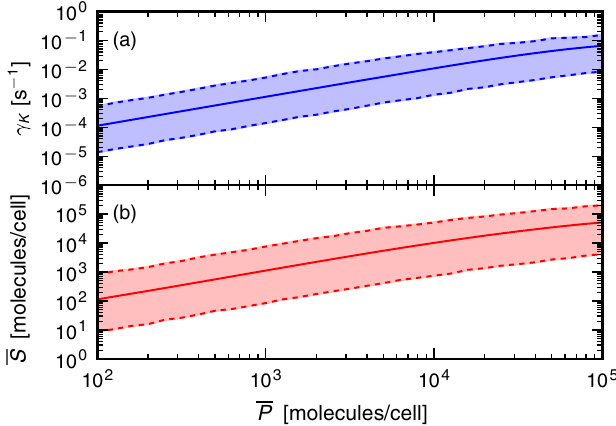
ffiffiffiffiffiffiffiffiffiffiffiffiffiffiffiffiffiffiffiffiffiffi p ρ ρ 2 − 2 ρ r þ FIG. 4. Conditions for WK optimality as the enzymatic push- pull loop parameters are varied. (a) The solid blue curve shows the relation between mean phosphatase population characteristic frequency scale γ input signal varies. This is at WK optimality [Eq. (5)], using the mapping of Eq. (11) and the parameter values κ listed in the text after Eq. (10). The shaded region between the dashed curves shows the 68% confidence interval for achieving WK optimality, resulting from randomly perturbing all the parameter values so that they can be up to tenfold smaller or larger. (b) Analogous to (a), but showing the relation between and substrate population